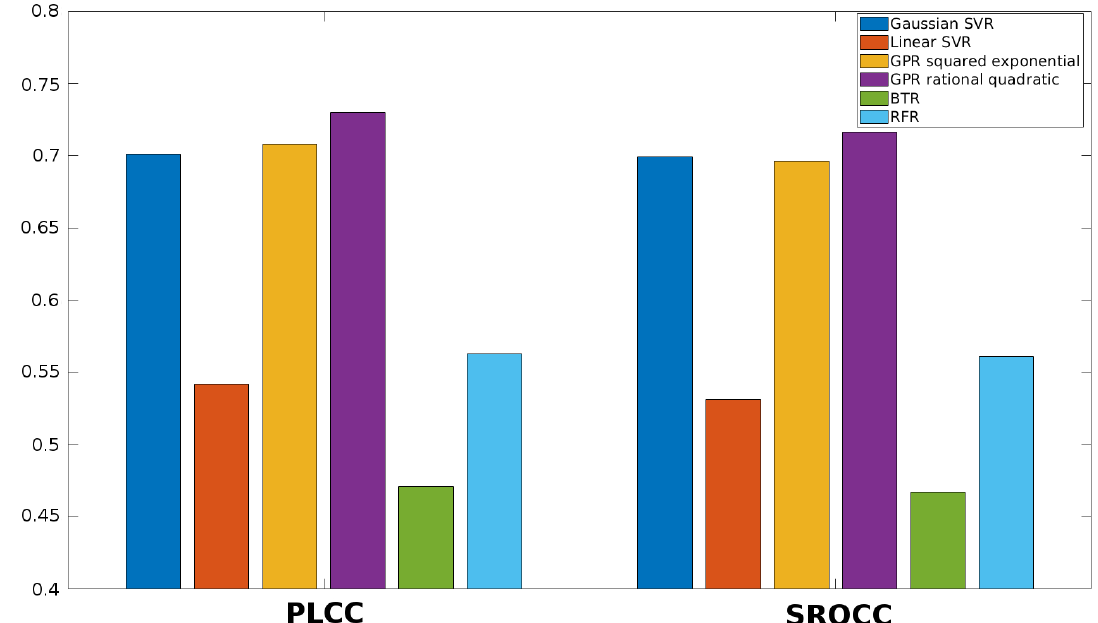
Figure 5. Comparison of different regression methods (SVR with Gaussian kernel function, SVR with linear kernel function, GPR with squared exponential kernel function, GPR with rational quadratic kernel function, BTR, and RFR). Mean PLCC and SROCC values were measured over 20 random train-test splits on KADID-10k [49].